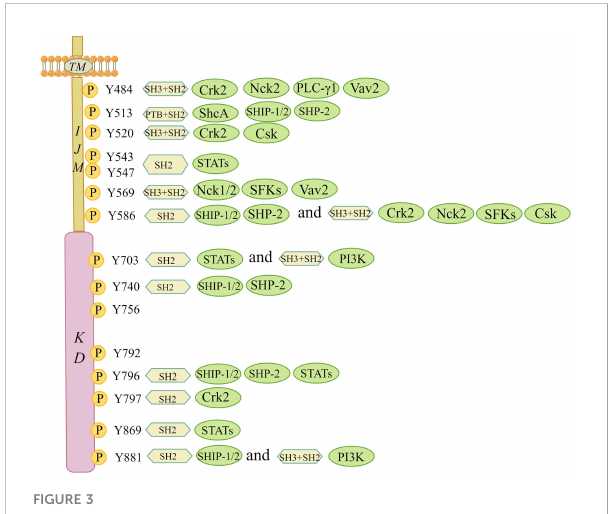
FIGURE 3 Interaction map of phosphotyrosine-based interactions of DDR1b isoform. This fi gure summarizes the tyrosine residue sites and corresponding interactors in the intracellular JM and kinase regions based on the study by Lemeer S et al. All phosphotyrosine interactors must rely on their SH2/3 and PTB domains in order to combine with the corresponding docking sites of tyrosine residues. Csk, C-terminal Src kinase; Crk2, adaptor protein Crk2; Nck1/2, adaptor protein Nck1/ 2; PI3K, phosphoinositide 3 kinase; PTB, phosphotyrosine-binding domain; PLC- g 1, phospholipase C g 1; SH2, Src homology 2 domain; SH3, Src homology 3 domain; ShcA, SH2-containing transforming protein A; SFKs, Src family tyrosine kinases; SHP-2, SH2 containing protein tyrosine phosphatase 2; SHIP-1/2, SH2-containing inositol polyphosphate 5- phosphatase 1/2; STATs, signal transducer and activator of transcriptions; TM, transmembrane domain; Vav2, guanine nucleotide exchange factor Vav2. (The fi gure is drawn by